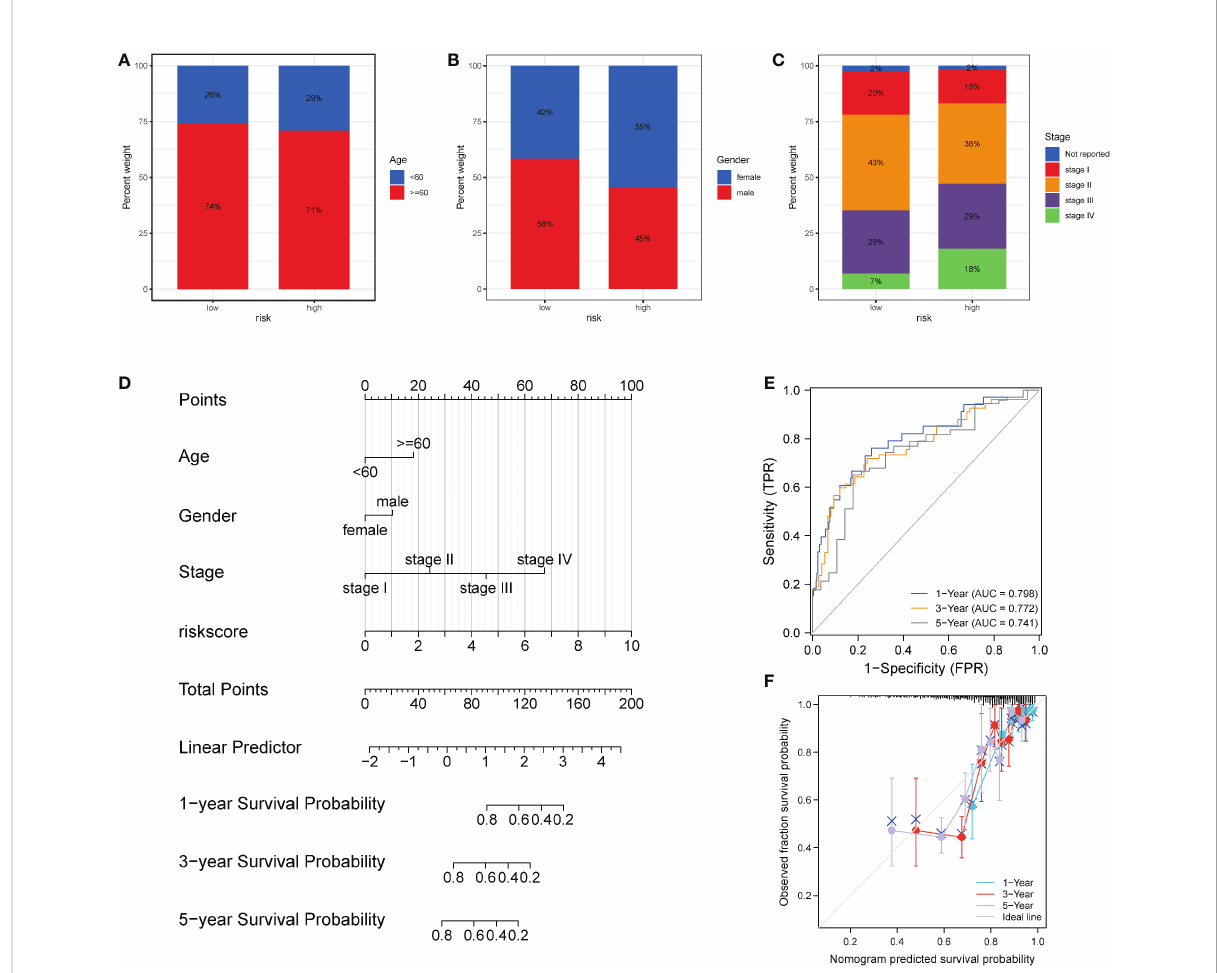
FIGURE 9 Performance of the necroptosis risk scores in the prediction of prognosis for patients with COAD. (A-C) Superimposed histogram showing the proportion of age, sex, and stage in patients in the high- and low-risk groups. The effect of age was similar in both groups, with an increased proportion of women in the high-risk group and signi fi cantly more advanced patients in the high-risk group. (D) Nomogram of the model. (E) Time-dependent ROC curve of the clinical prediction model based on risk score. (F) For the calibration curve of the nomogram, the bootstrap method was adopted, and resampling was performed 1000 times. The abscissa is the survival predicted by the nomogram, and the ordinate is the actual observed survival. The calibration plot revealed that the bias-corrected line for 1-, 3-, and 5- years OS was close to the ideal line, indicating good consistency between the predicted value and the actual